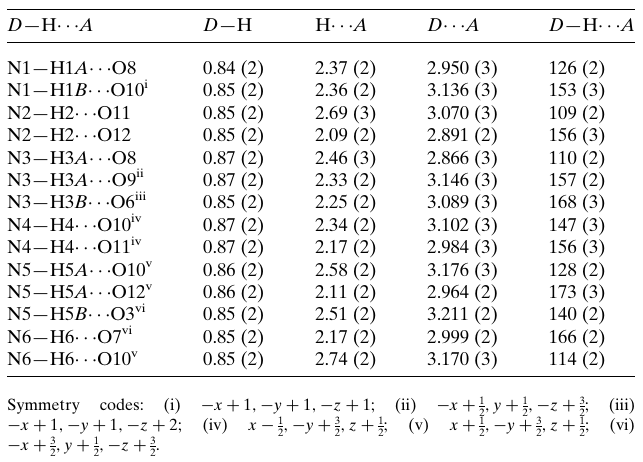
Table 1 Hydrogen-bond geometry (A˚ , (cid:3)